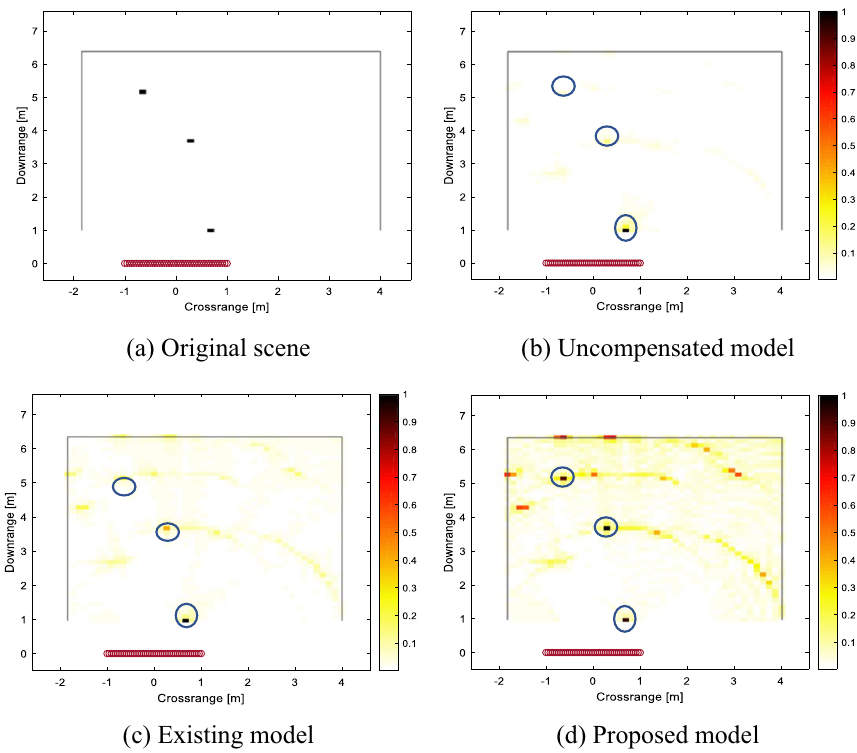
Fig. 9 Images from Delay-and-Sum Beamforming in three target